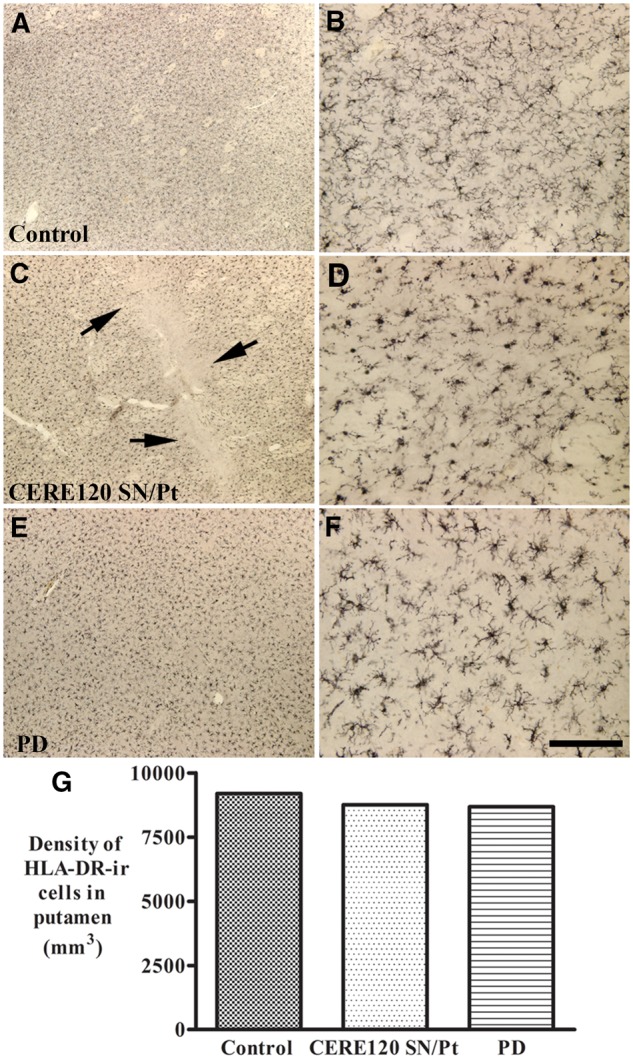

Qualitative and quantitative evaluation for micoglial cells in putamen with or without CERE120 delivery. Sections from putamen show human leucocyte antigen-DR isotype (HLA-DR) immunoreactive patterns in age-matched control (A and B), Parkinson’s disease with combined nigral and putamenal CERE120 delivery (C and D), and Parkinson’s disease without gene delivery (E and F). Note that the intensity and morphology of HLA-DR labelling cells in brain (C and D) with CERE120 delivery were similar to the age-matched control (A and B) and Parkinson’s disease without gene delivery (E and F). Arrows in C indicate a needle track for CERE120 delivery. Scale bar in F = 100 µm for B and D and 1.6 mm for A, C, E. Stereological analyses revealed that density of HLA-DR immunoreactive (HLA-DR-ir) cells in Parkinson’s disease with CERE120 delivery was similar to age-matched control and Parkinson’s disease without gene delivery (G). PD = Parkinson’s disease; ir = immunoreactivity.